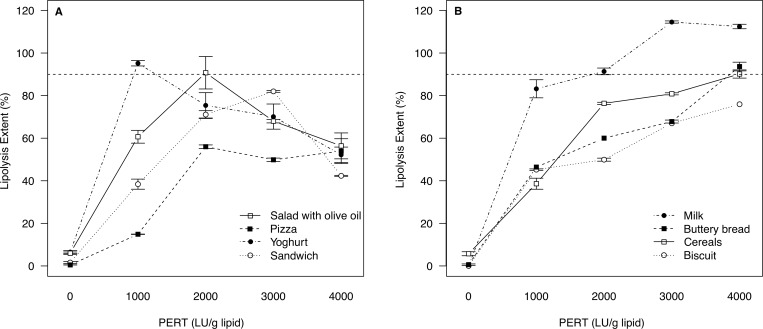
Lipolysis extent (%) versus different doses of enzymatic supplement (LU/g lipid) after in vitro digestion (intestinal pH 6 and 1 mM bile salt concentration).The horizontal dotted line represents a 90% of lipolysis extent target. Fig 1A: foods with a decreasing lipolysis extent with dose; Fig 1B: foods with an increasing lipolysis extent with dose.